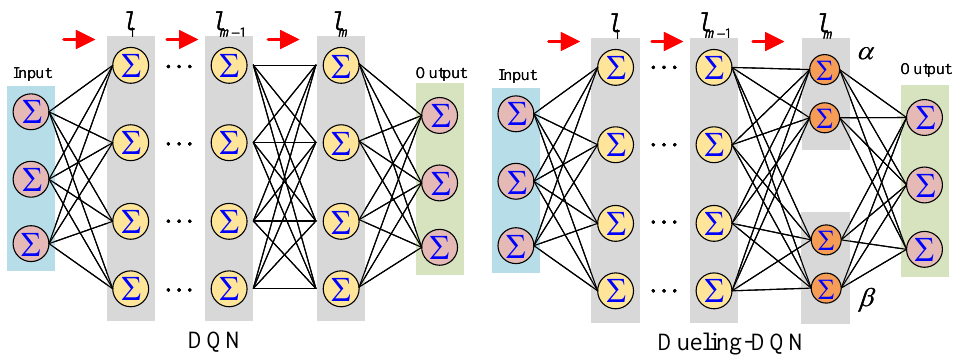
Figure 3. Difference between the networks in DQN ( left ) and dueling DQN ( right ).